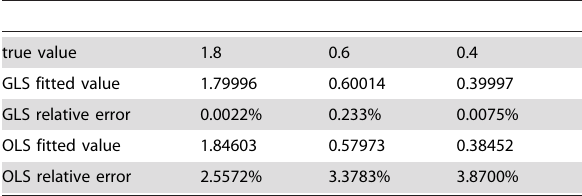
Table 2. Two-stage estimates of b OLS.